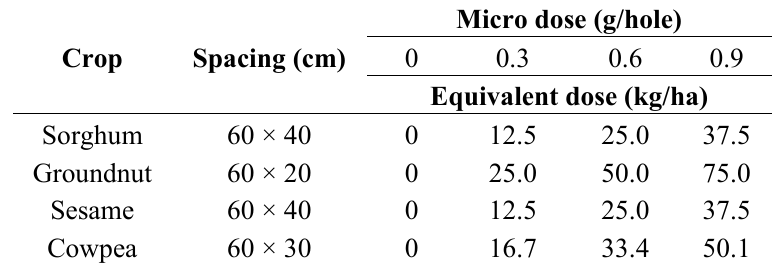
Table 1. Calculated fertilizer quantity in kg·ha −1 corresponding to fertilizer micro-dose level per planting